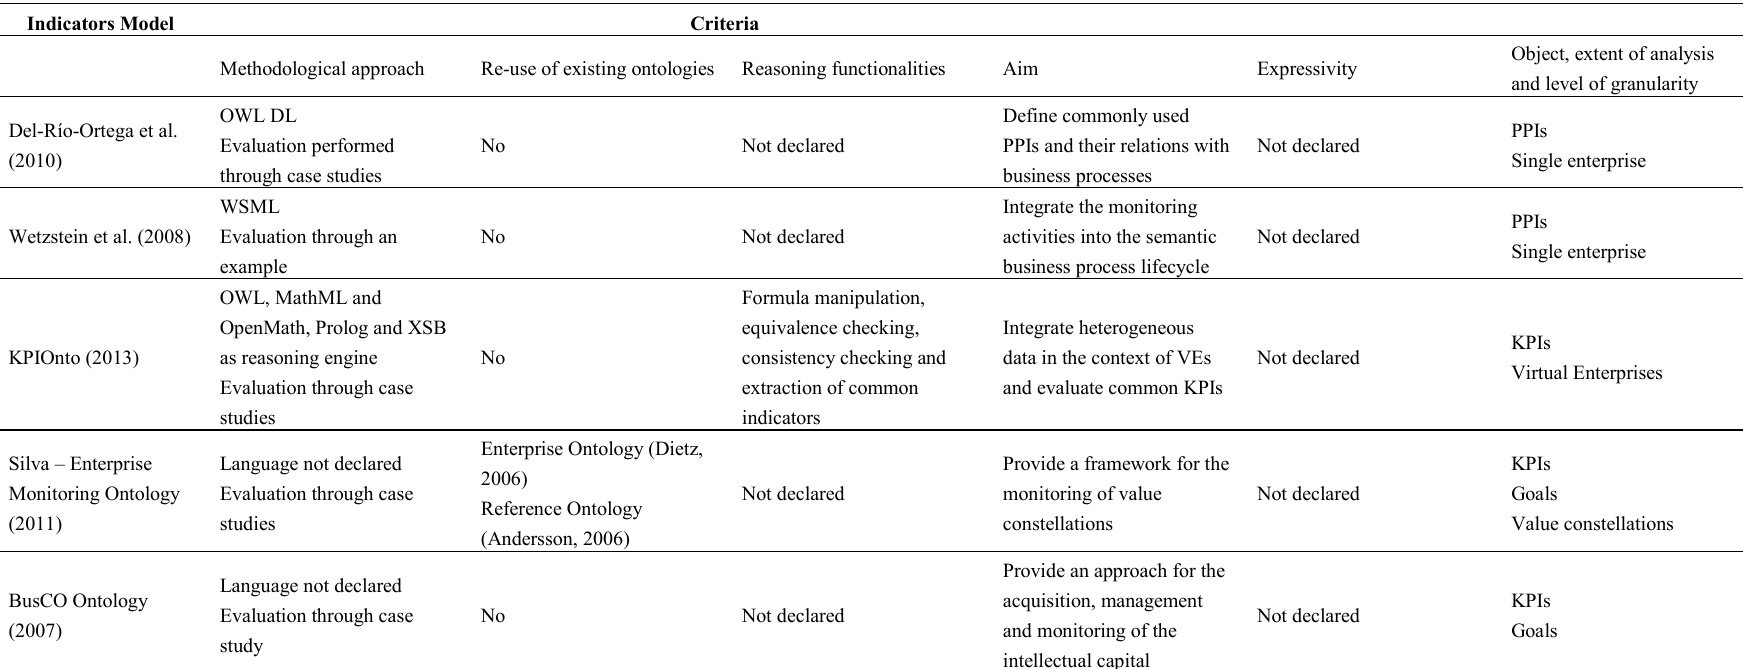
Table 6. Classification of